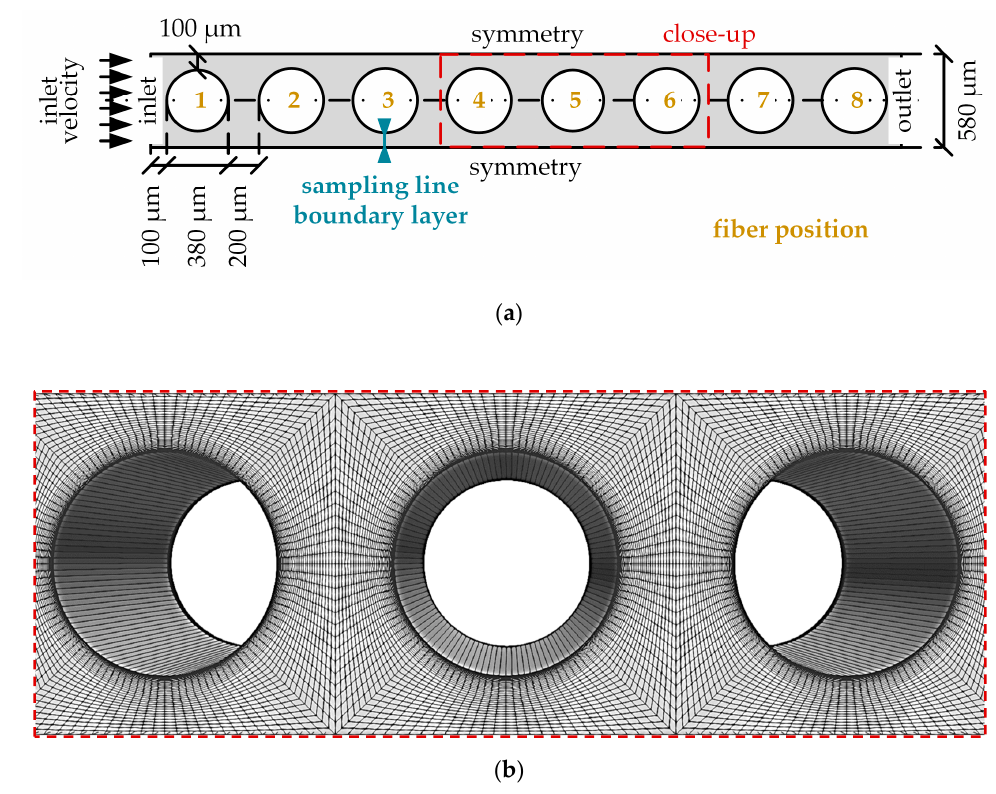
Figure 7. Simplified geometry of CFD CO 2 transport simulations. ( a ) Fibers representing the eight fiber layers of the membrane packing positioned in a non-staggered arrangement, ( b ) close up of the computational mesh.